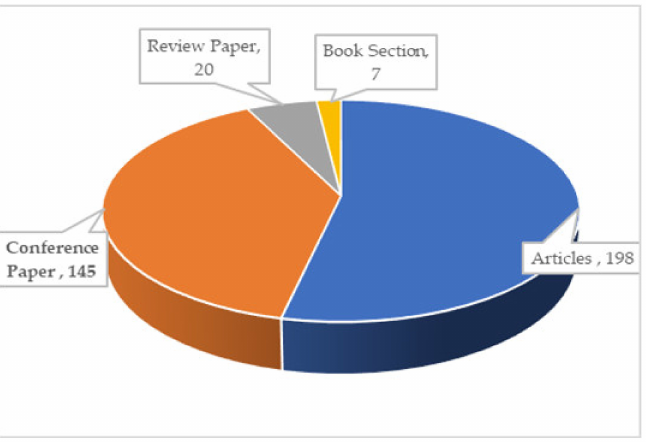
Figure 9. Overall distribution of document types of 370 original articles shortlisted through SCOPUS and IEEE Xplore online libraries after applying search keywords in Phase I, Phase II and Phase III.